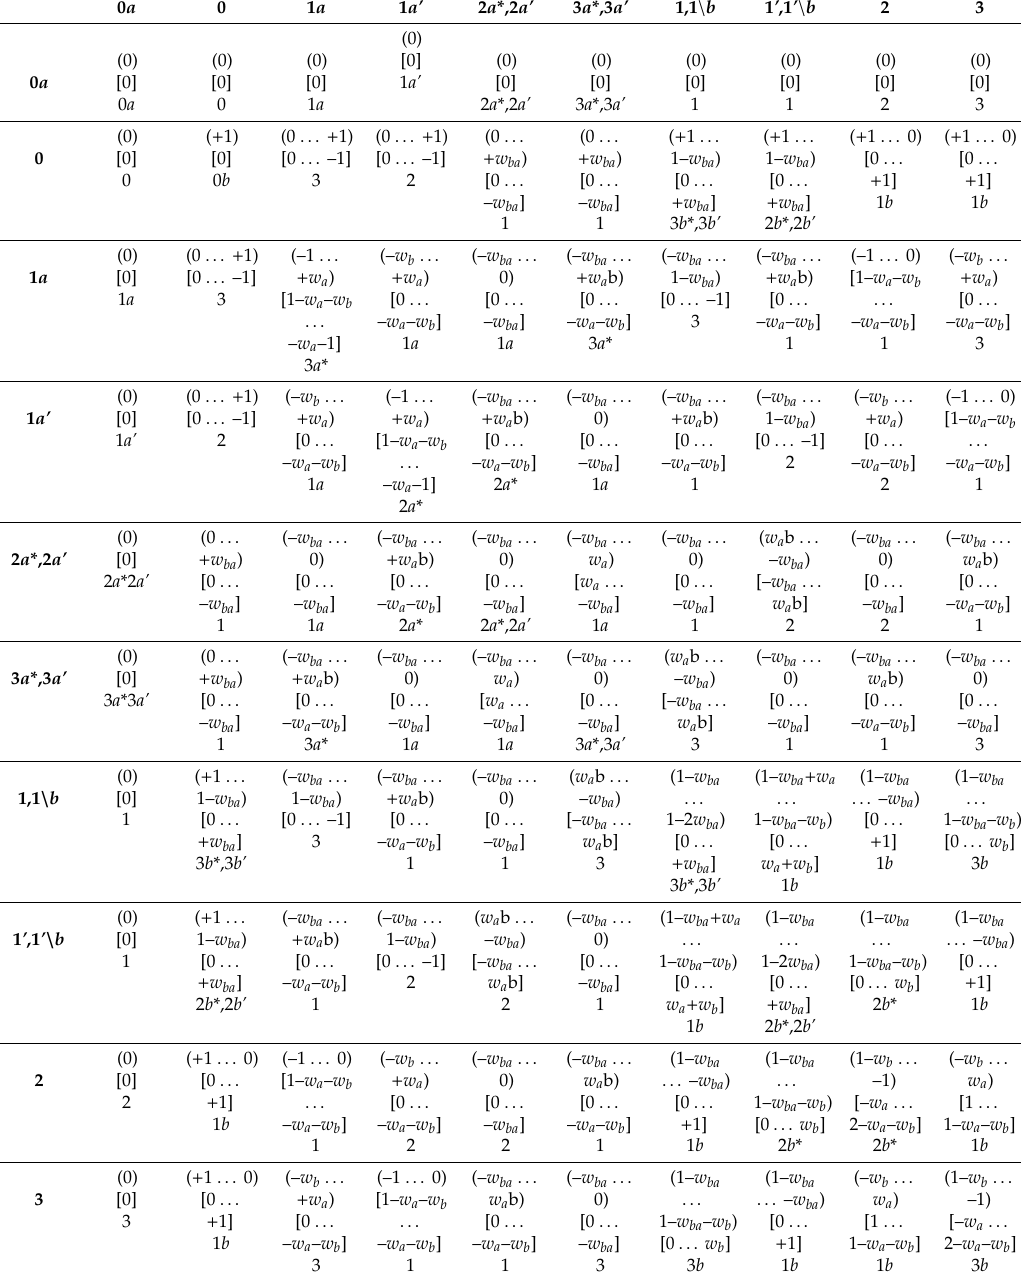
Table 2. Results of joining extremities of chains with types specified in a row and column; the type of resulting chain is given at the bottom of a